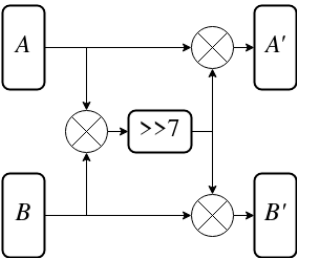
Figure 9. Feistel-like P-BOX of IJON.